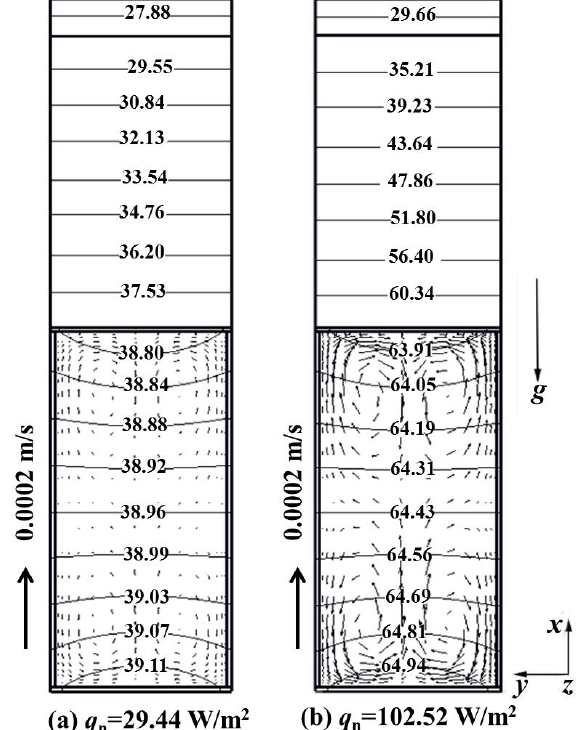
Fig. 8. The velocity and temperature fields when the test wall is posited horizontally (z=0.0025 mm): (a) q n = 29.44 W/m 2 ; (b) q n = 102.52 W/m 2